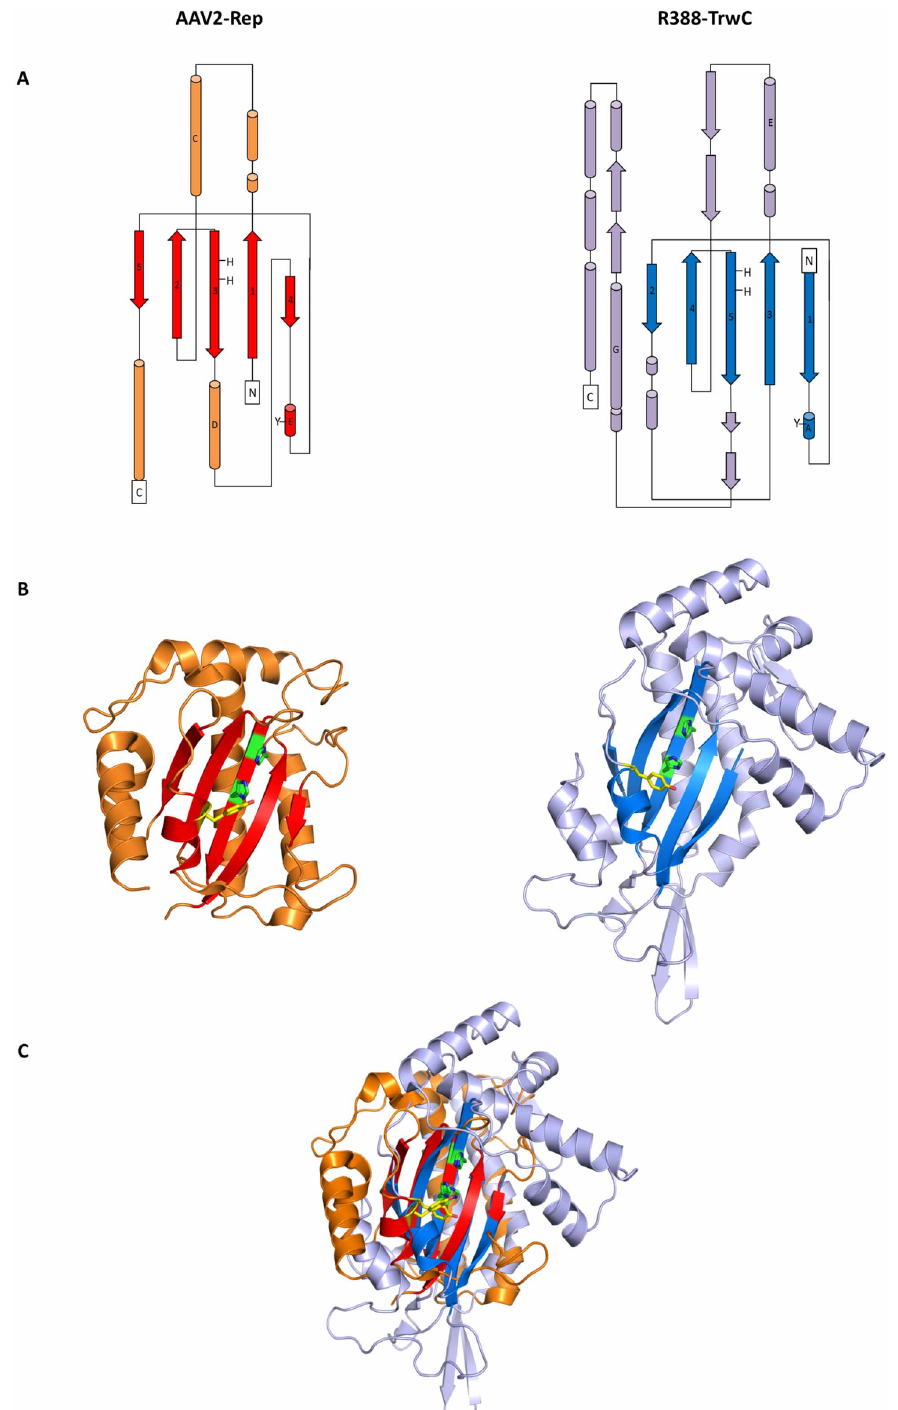
Fig 1. Structural similarities between the N-terminal domains of AAV2-Rep and R388-TrwC. (A) Topology diagram of the OBD domain of Rep (left) and relaxase domain of TrwC (right). The portion of the structure that forms the core active site typical of HUH endonucleases, consisting of five anti-parallel β -sheets and one α -helix and containing the active site tyrosine (helix E in AAV-Rep and helix A in R388-TrwC), is highlighted in red and blue, respectively. Helices with some degree of overlap are shown with their name (C and D in AAV-Rep, E and G in R388-TrwC). (B) Ribbon diagrams shown in the same orientation as in (A), with the active site tyrosine highlighted